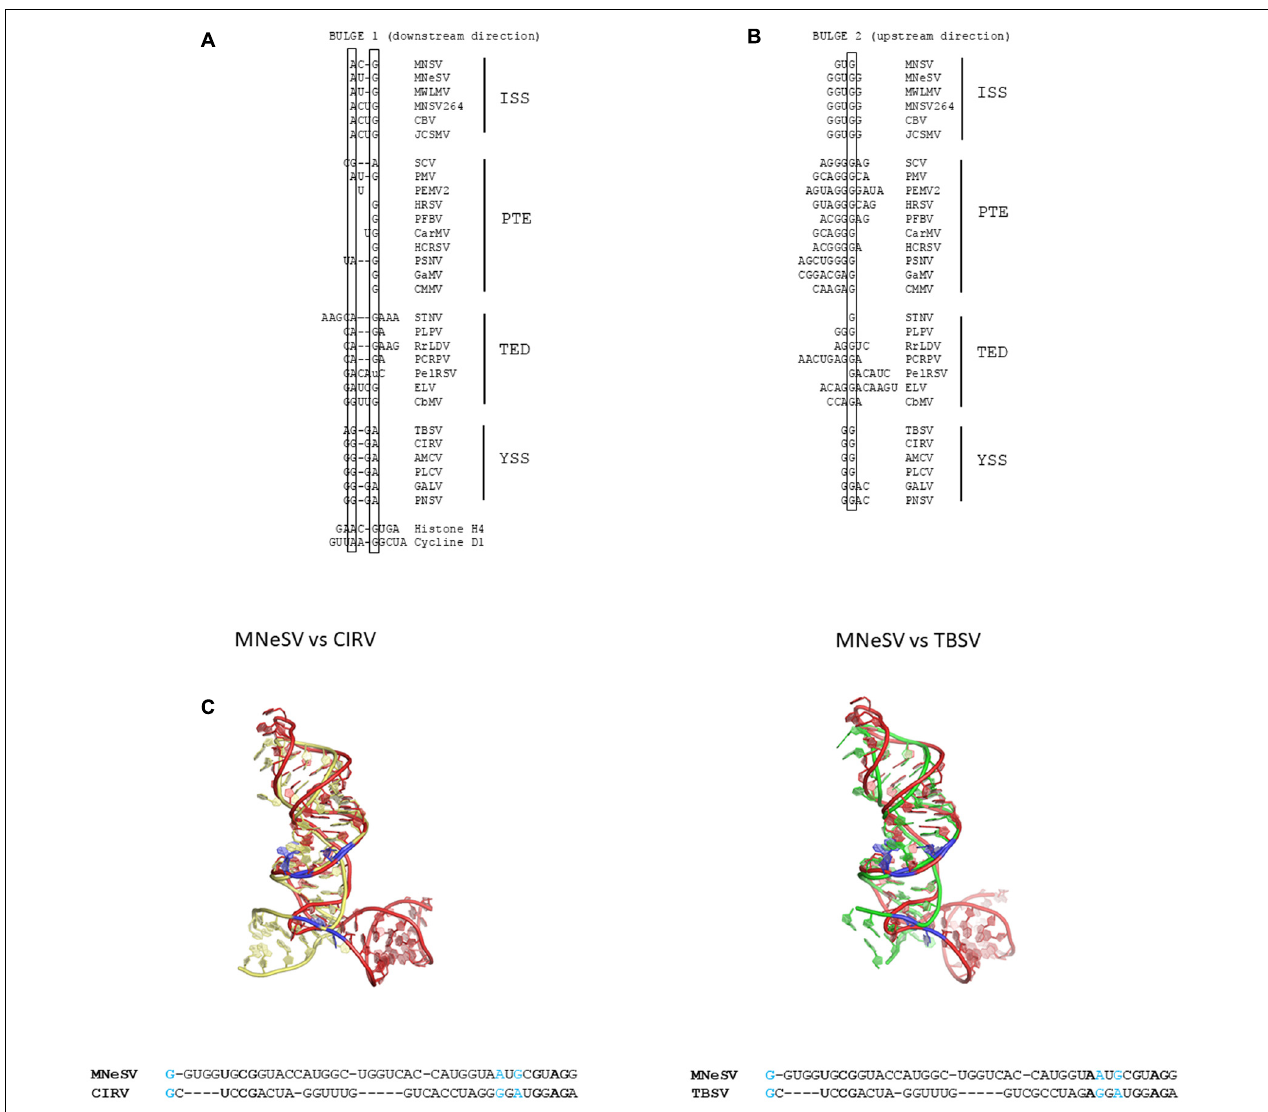
FIGURE 4 | Conservation of unpaired 3 (cid:48) -CITE residues suggested to be involved in eIF4E binding. (A) Residues of the first bulge present downstream of the final stem-loop of ISS, PTE, TED, and YSS CITEs and of the histone H4 and cyclin D1 4E-sensitivity elements. (B) Residues of the second bulge present upstream of the final stem-loop of these 3 (cid:48) -CITEs. Conserved adenosine [in (A) , similar to A32 of MNSV ISS] and guanosine residues [similar in (A) to G47 of MNeSV ISS and in (B) to G13 of MNeSV ISS and the highly reactive G17 residue from the G-domain of PTE] are framed. (C) 3D structural alignment [Rclick server (Nguyen et al., 2017)] of the left arm of the YSS of CIRV and TBSV (colored in yellow and green, respectively) with the ISS of MNeSV (red colored), based on the predicted tertiary structures [RNAComposer server (Popenda et al., 2012)]. YSS of CIRV and TBSV and ISS of MNeSV are based on data derived from Nicholson et al. (2010, 2013), respectively. Below, alignment of sequence stretch of both structures aligning in the 3D prediction (Rclick server). Identity of residues is emphasized in bold. Adenosine and guanosine residues predicted to be important for eIF4E binding are shown in blue in the 3D structural alignment and in red in the sequence